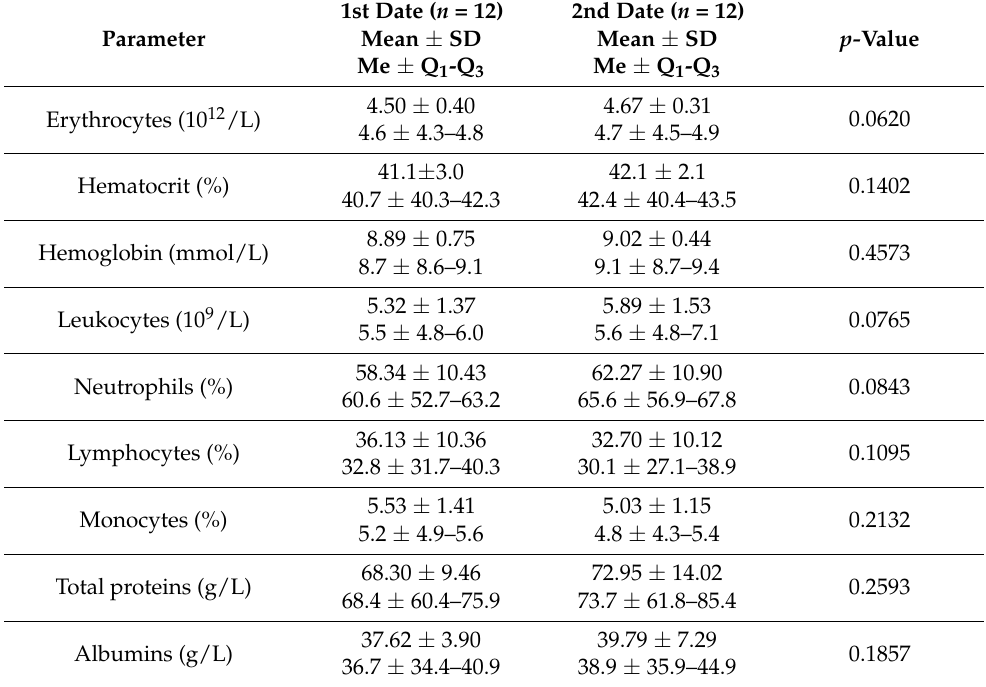
Table 2. Values of selected hematological and biochemical blood parameters in sessions 1 and 2.